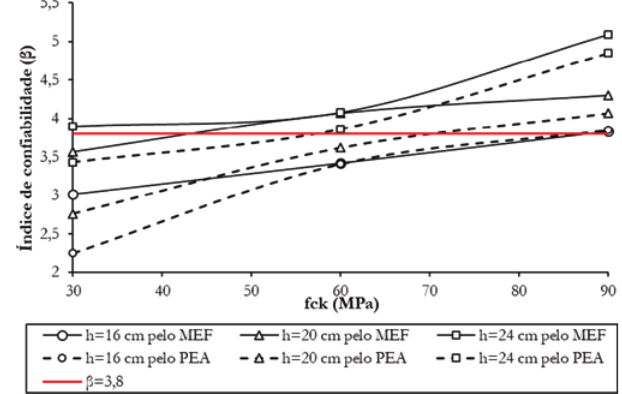
Análise do índice de confiabilidade para as lajes com altura=16 cm